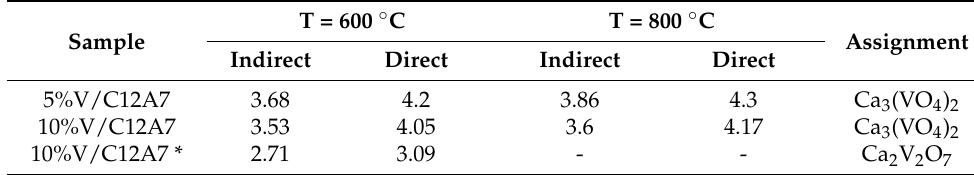
Table 1. The estimated values of E g for the 5%V/C12A7 and 10%V/C12A7 samples.